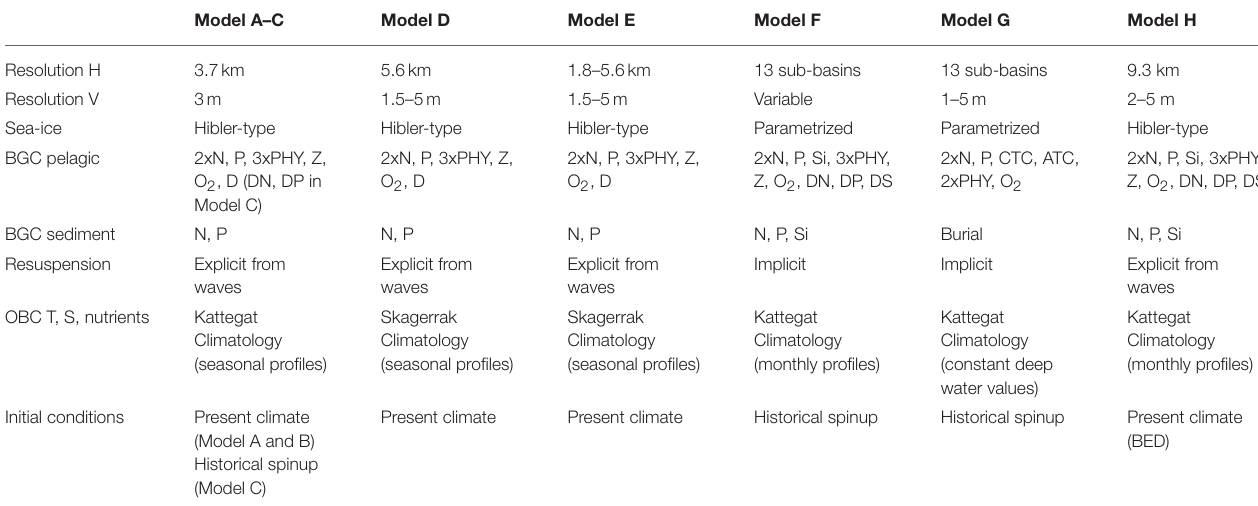
TABLE 1 | Baltic Sea models (N, nitrogen; P, phosphorus; Si, silica; CTC, total inorganic carbon; ATC, total alkalinity; PHY, phytoplankton; O 2 , oxygen (or hydrogen sulfide); D, dead organic matter; Z, zooplankton; H, horizontal; V, vertical; BGC, biogeochemical cycling; OBC, open boundary conditions; T, temperature; S, salinity; BED, Baltic Environmental